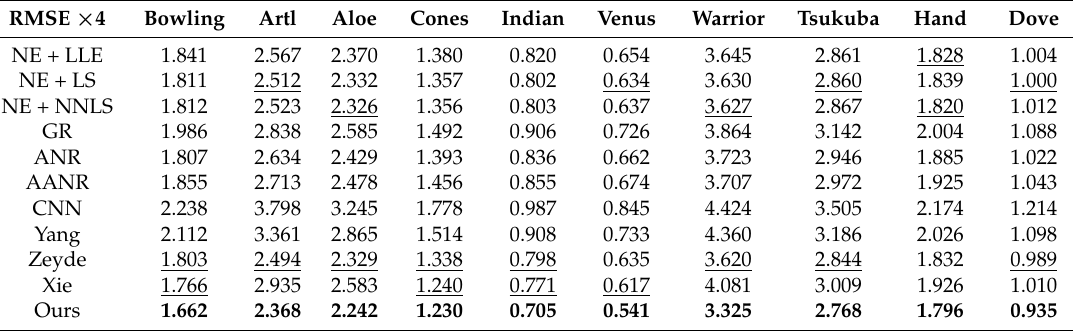
Table 1. RMSE values on the Middlebury Stereo database with scaling factor of 4.